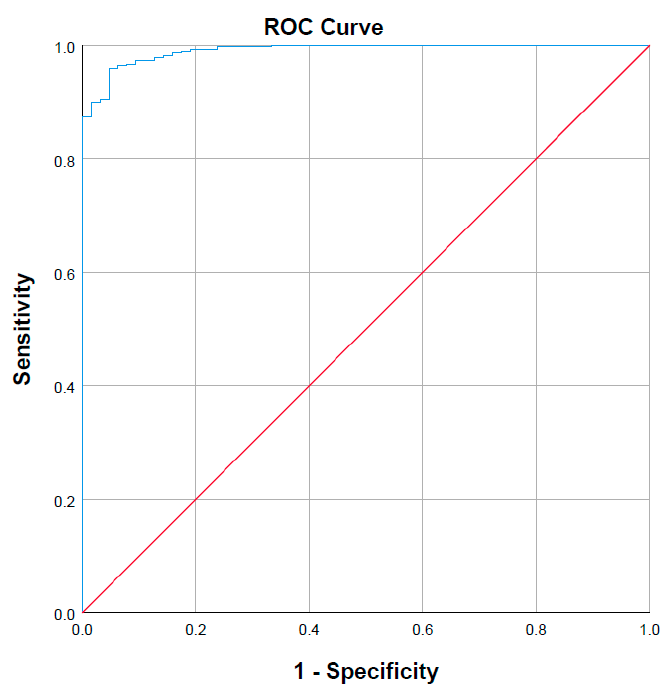
Figure 3. Receiver operating characteristic (ROC) curve demonstrating the prediction performance of a predicted steady state sorafenib AUC.